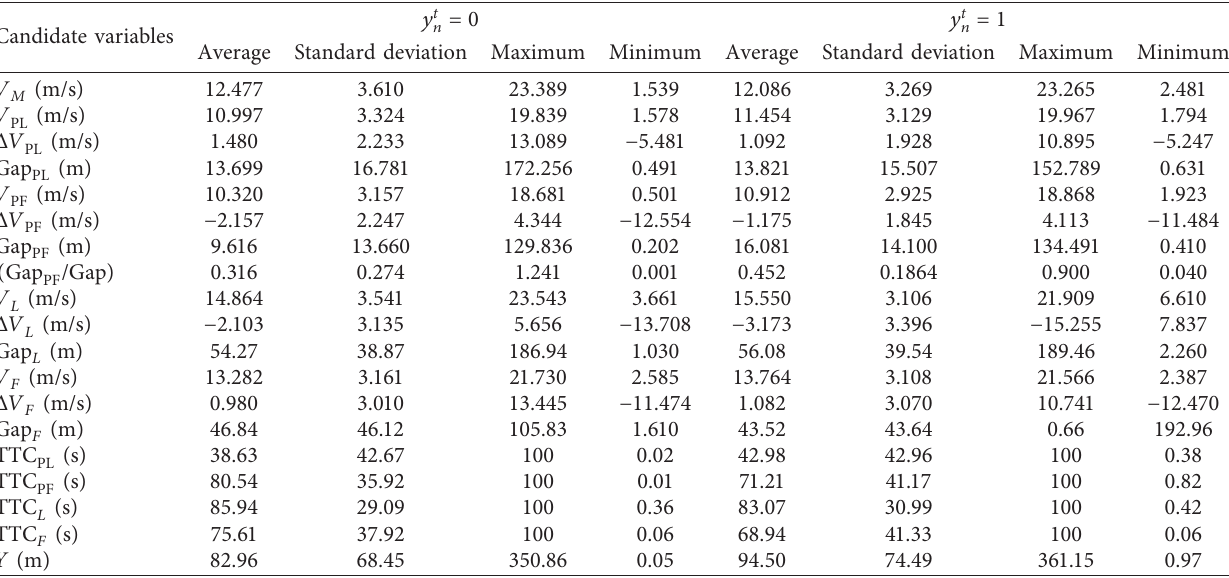
Table 3: Statistics of candidate influencing variables.